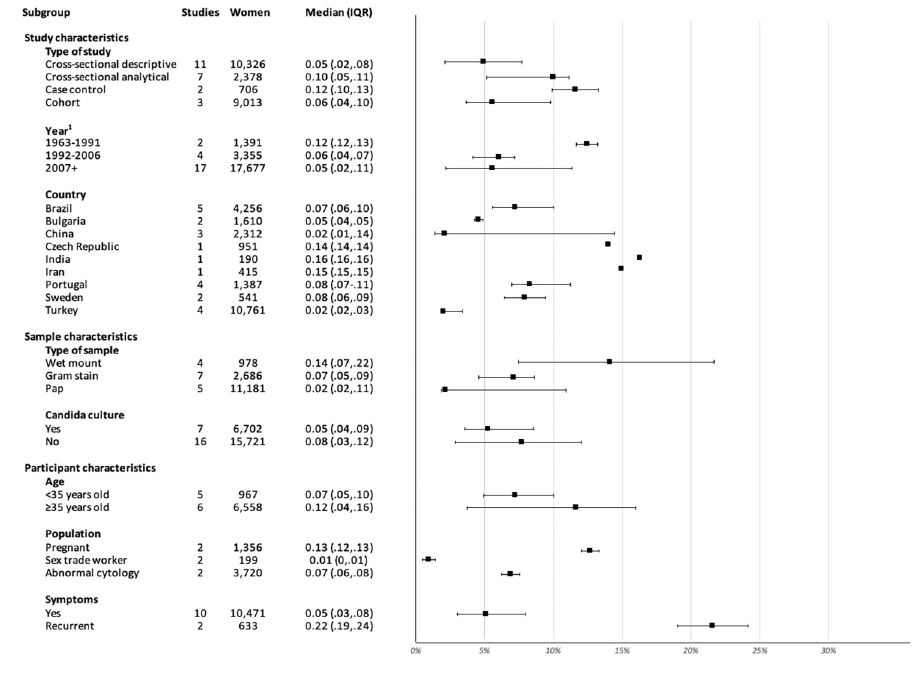
Fig 2. Median prevalence by subgroup. 1. The cut-off of the first group is based on the year of Cibley e’ al.’s study [7] on CV, and the cut-off for the subsequent groups was chosen to divide the remaining years equally between groups.